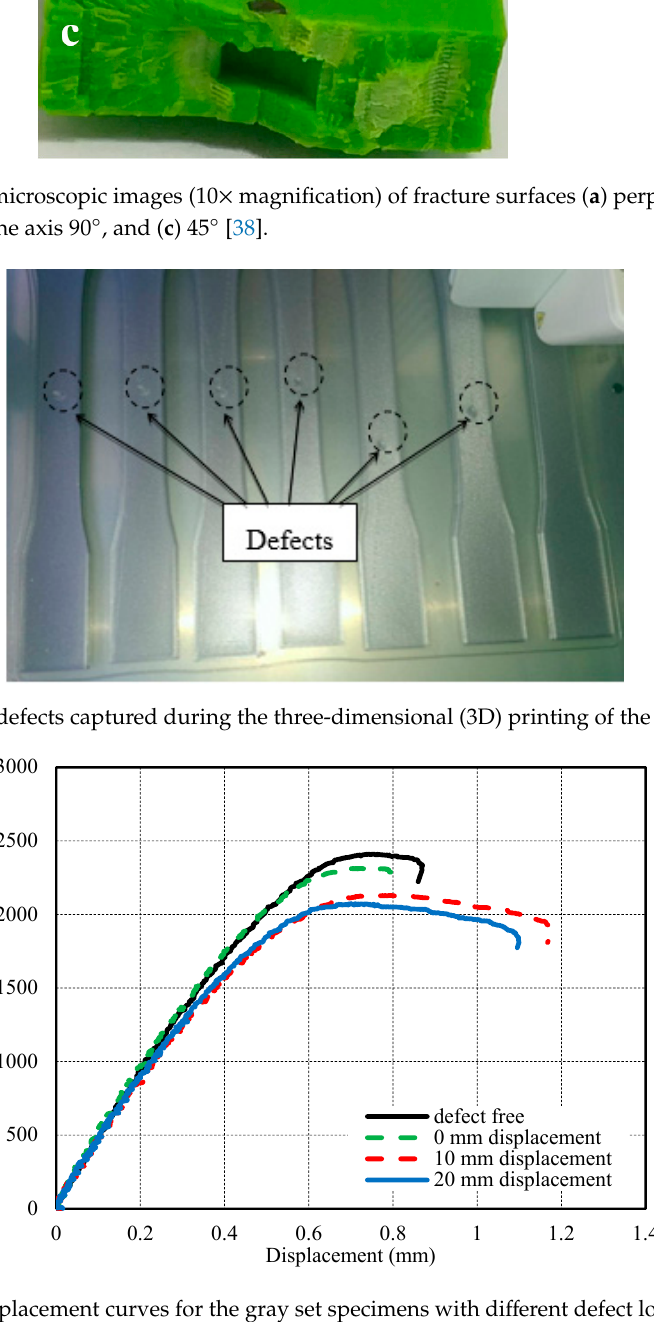
Figure 9. Effect of the defect’s location on the peak load for gray samples. Similarly, the influence of the defect’s orientation was investigated for gray samples, as presented in Figure 10. The force-displacement curves of these gray samples have almost the same trend as for the curves of the green samples set. Figure 11 compares the reference case and the oriented, internal defects at the center of the gauge length. The impact of the defect’s orientation is obvious. Noticeable differences were recognized at the last stage where the “defect-free” case showed the highest value, and the “defect perpendicular to the axis” showed the lowest value, of the failure load.